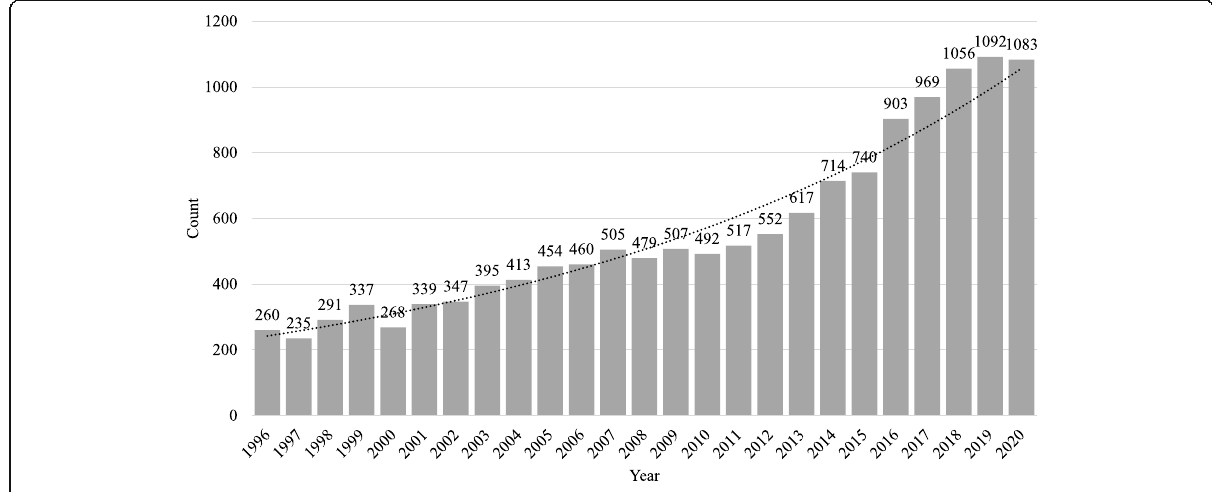
Fig. 3 Light field imaging timeline: numbers of publications whose titles contain keywords “ light field ” or “ light fields ” or “ light-field ” or “ ray space ” from 1996 to 2020 (the dotted line is the geometric